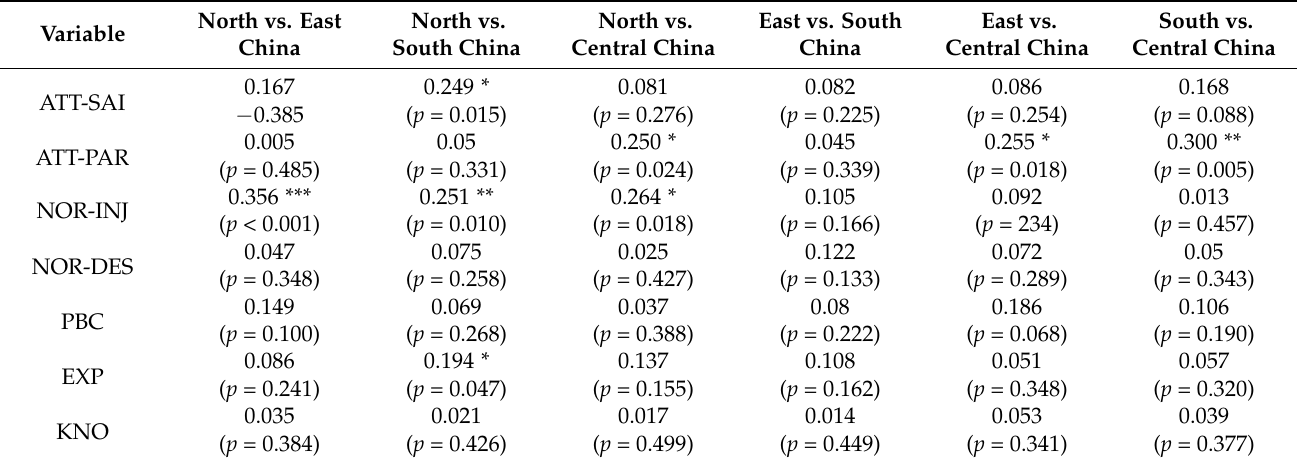
Table A5. Absolute differences in path coefficients by